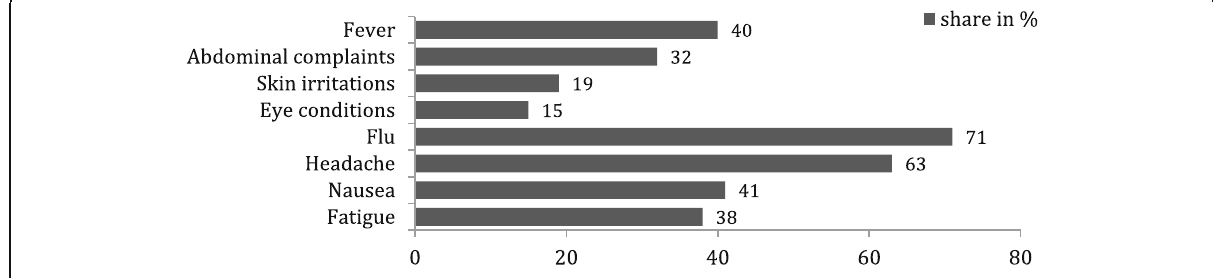
Fig. 4 Syndromic surveillance of self-reported symptoms in a wetland community of the Ewaso Narok Swamp (n =